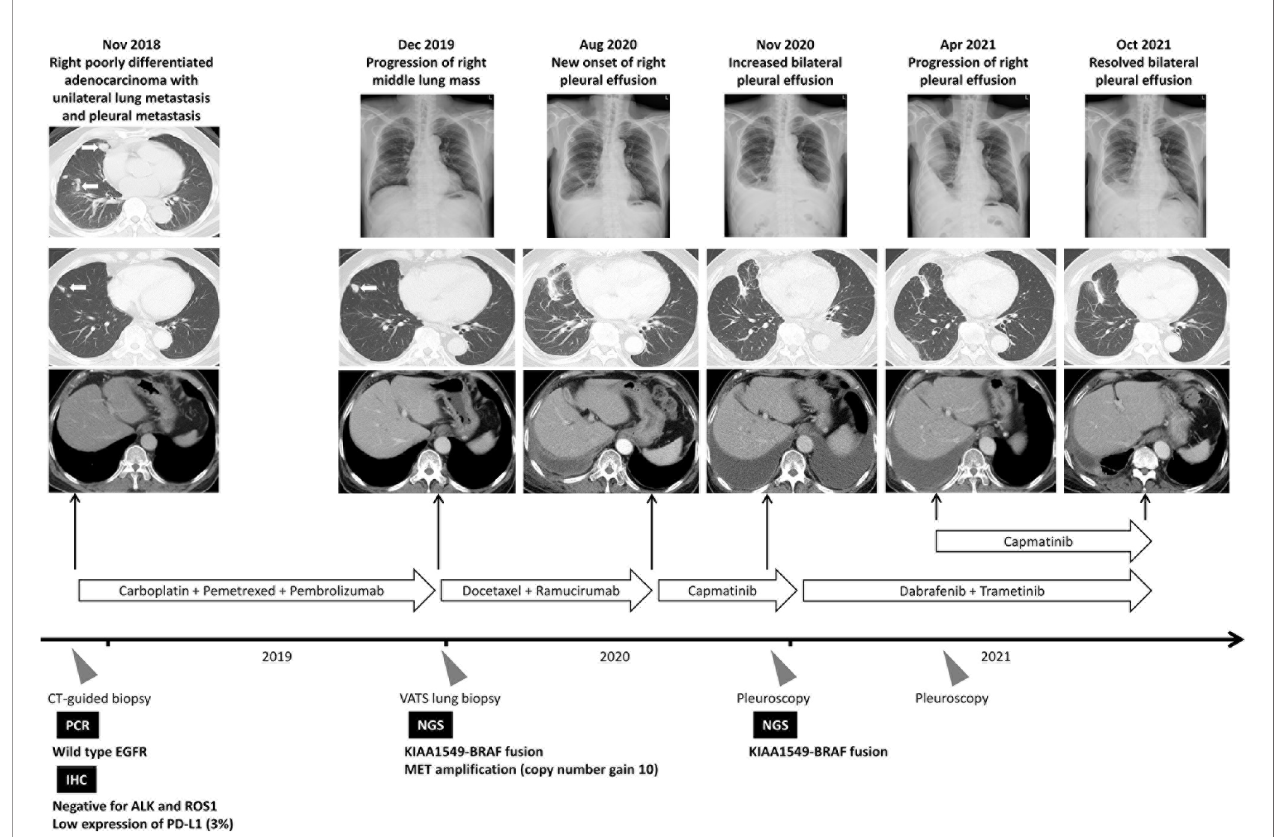
FIGURE 2 | Summary of treatment courses mentioned in this case report. The white arrows indicate the target lesion in the serial image study. ALK , anaplastic lymphoma kinase; CT, computed tomography; EGFR , epidermal growth factor receptor; IHC, immunohistochemical; NGS, next-generation sequencing; PCR, polymerase chain reaction; ROS1 , ROS proto-Oncogene 1; VATS, video-assisted thoracic